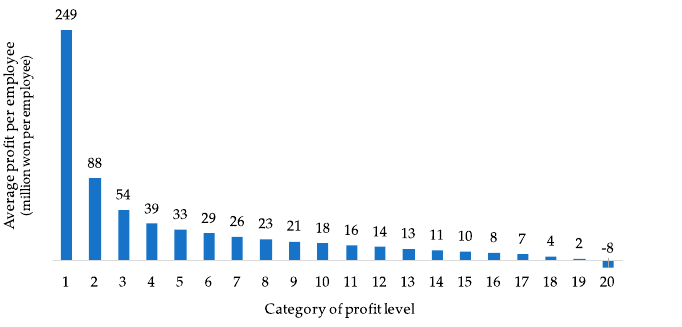
Figure 1. Categories of industry by profit per employee (the negative value means loss). GIS coordinates of city halls and county offices were used as central coordinates of the regions.